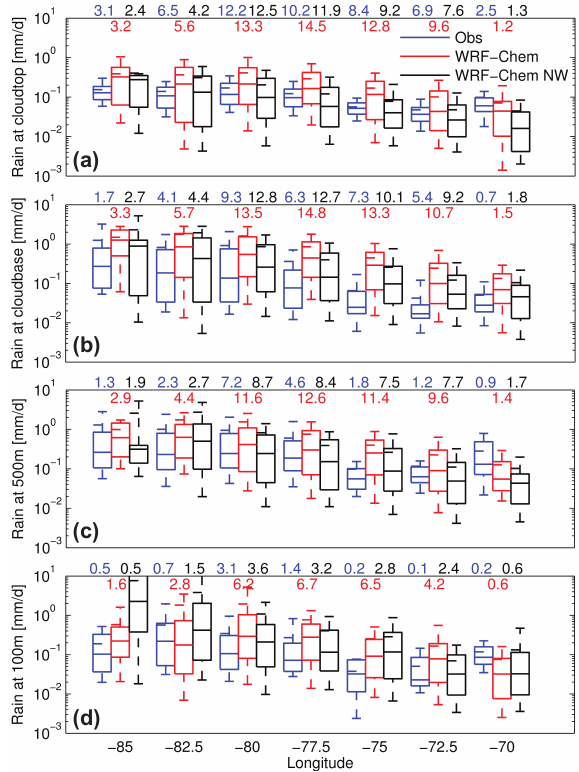
Fig. 6. Box and whisker plots for radar derived and modeled rain at different heights as in Fig. 1. (a) and (b) corresponds to rain rates just below the cloud top and at the cloud base while (c) and (d) corresponds to rain rates at fixed heights of 500 and 100m. The numbers above each zone represent sampling time in decimal